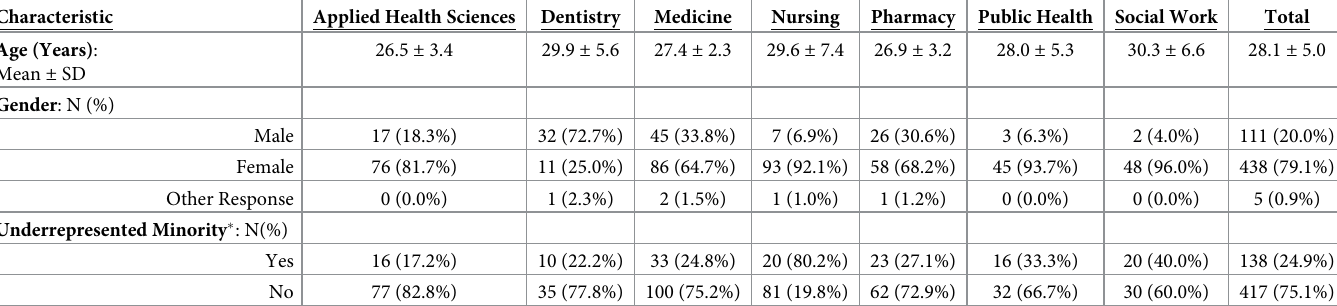
Table 5. Baseline characteristics of participants enrolled as of May 5, 2021 (after first of three recruitment waves).